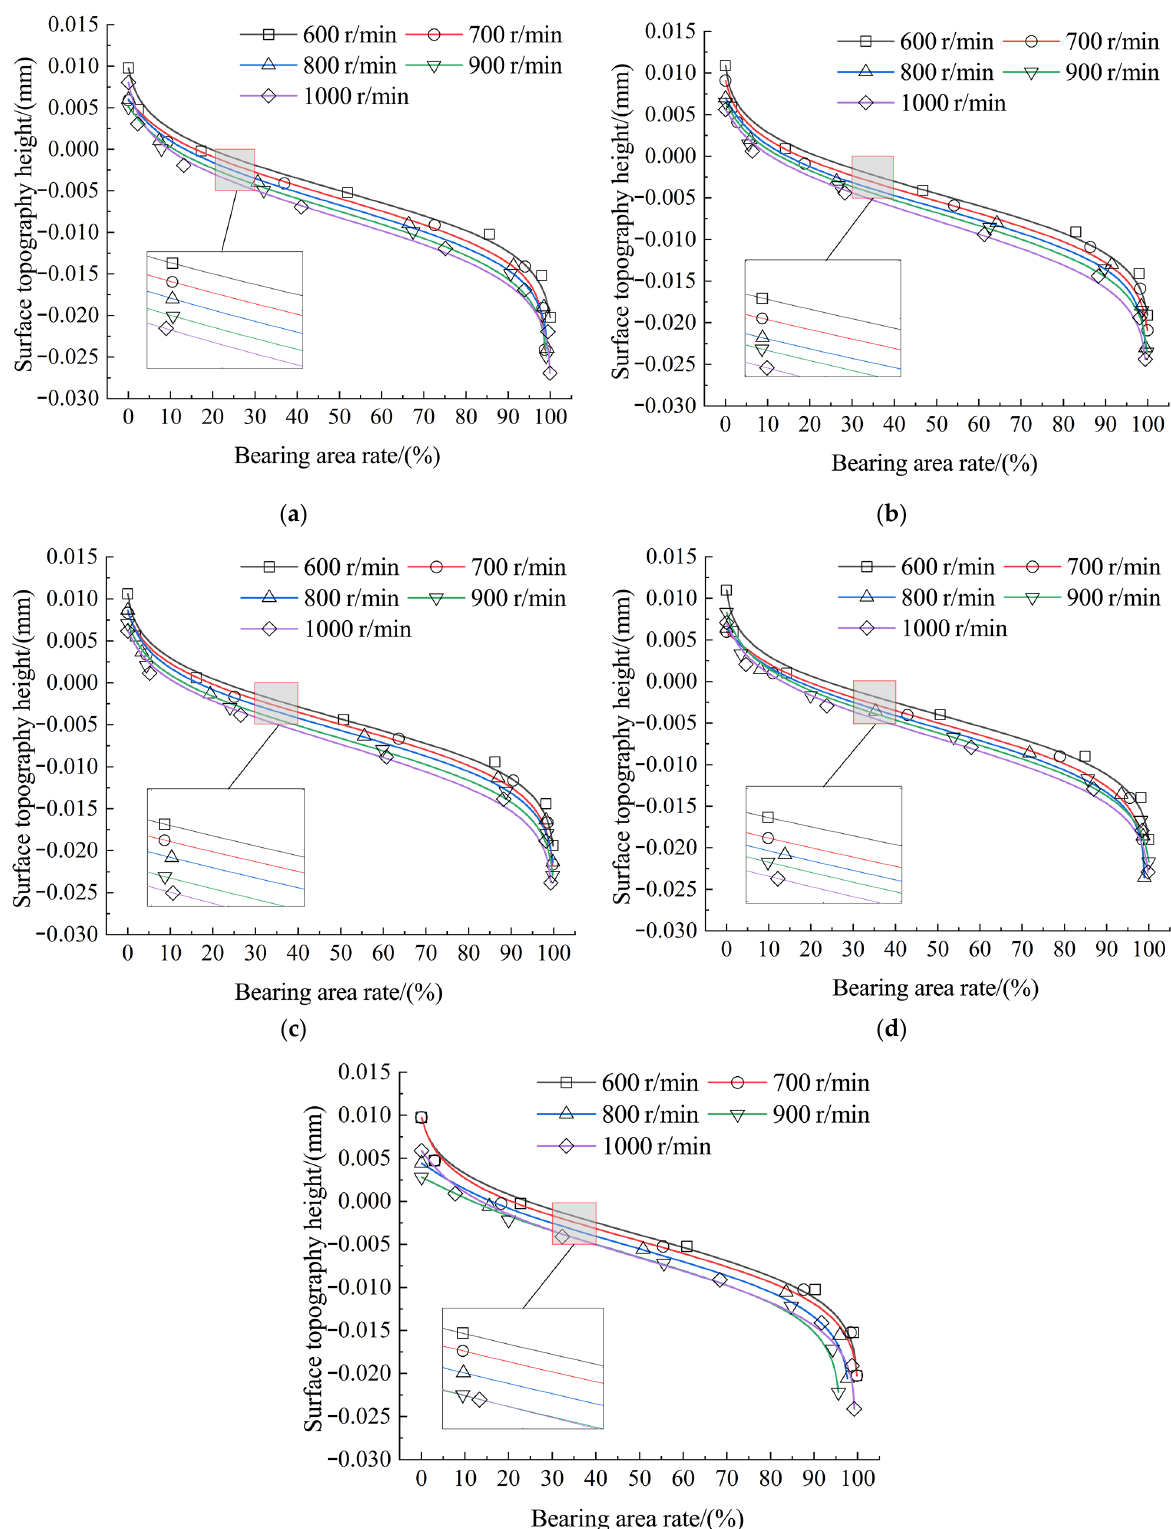
Figure 19. Effect of friction parameters on bearing area curves of surface topography. ( a ) The external load is 50 N; ( b ) the external load is 70 N; ( c ) the external load is 90 N; ( d ) the external load is 110 N; ( e ) the external load is 130 N.